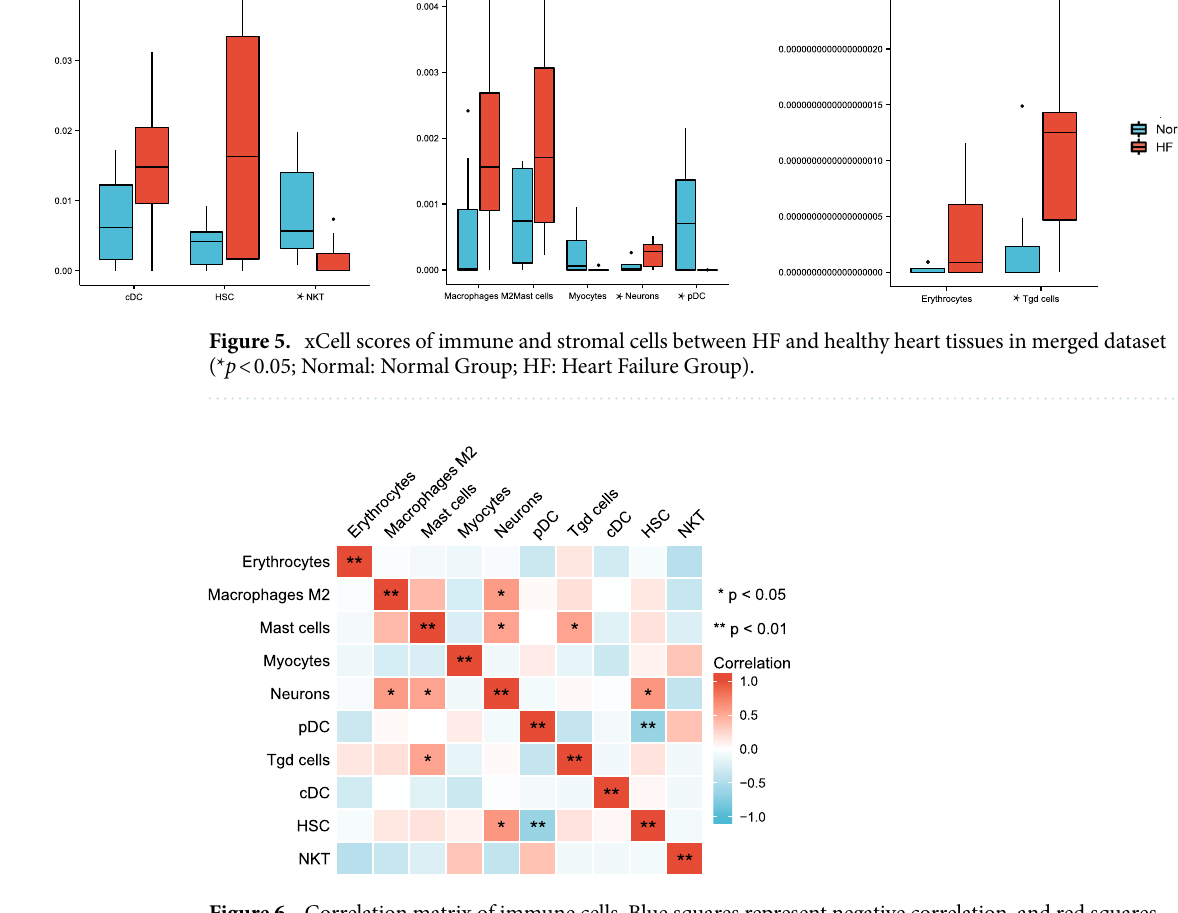
Figure 6. Correlation matrix of immune cells. Blue squares represent negative correlation, and red squares represent positive